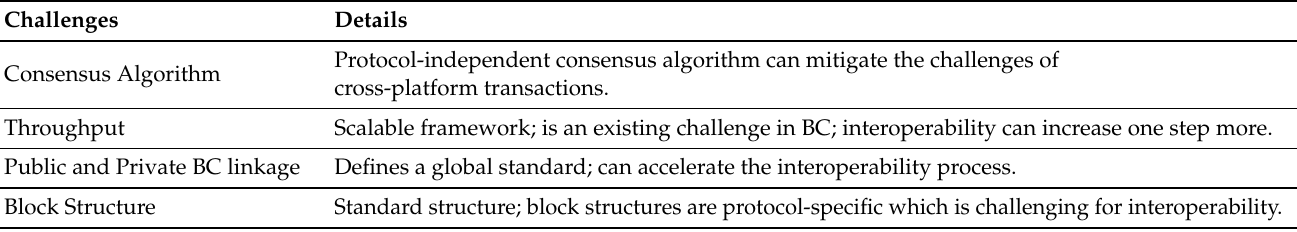
Table 3. Future research